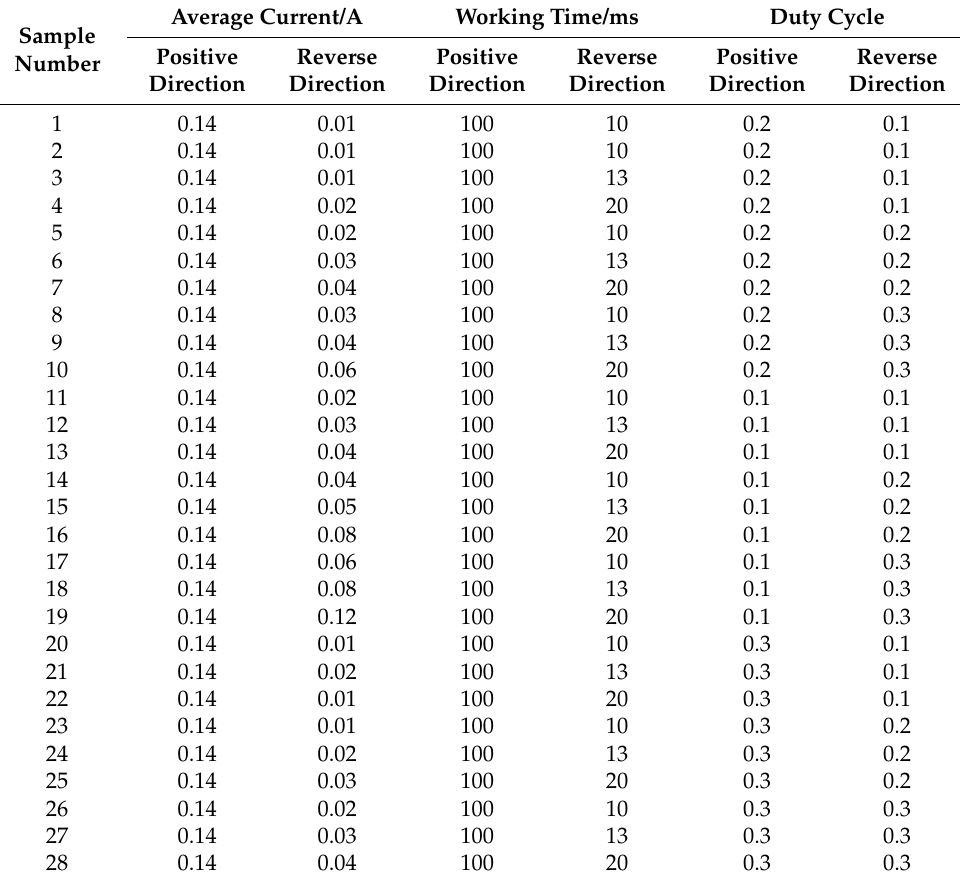
Table 1. Selection of process parameters for double-pulse electrodeposition.